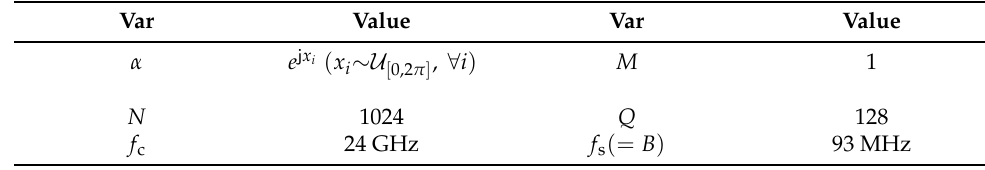
Table 3. Simulation settings for comparing COS and DCOS, which are with reference to [12] [Tab.2].